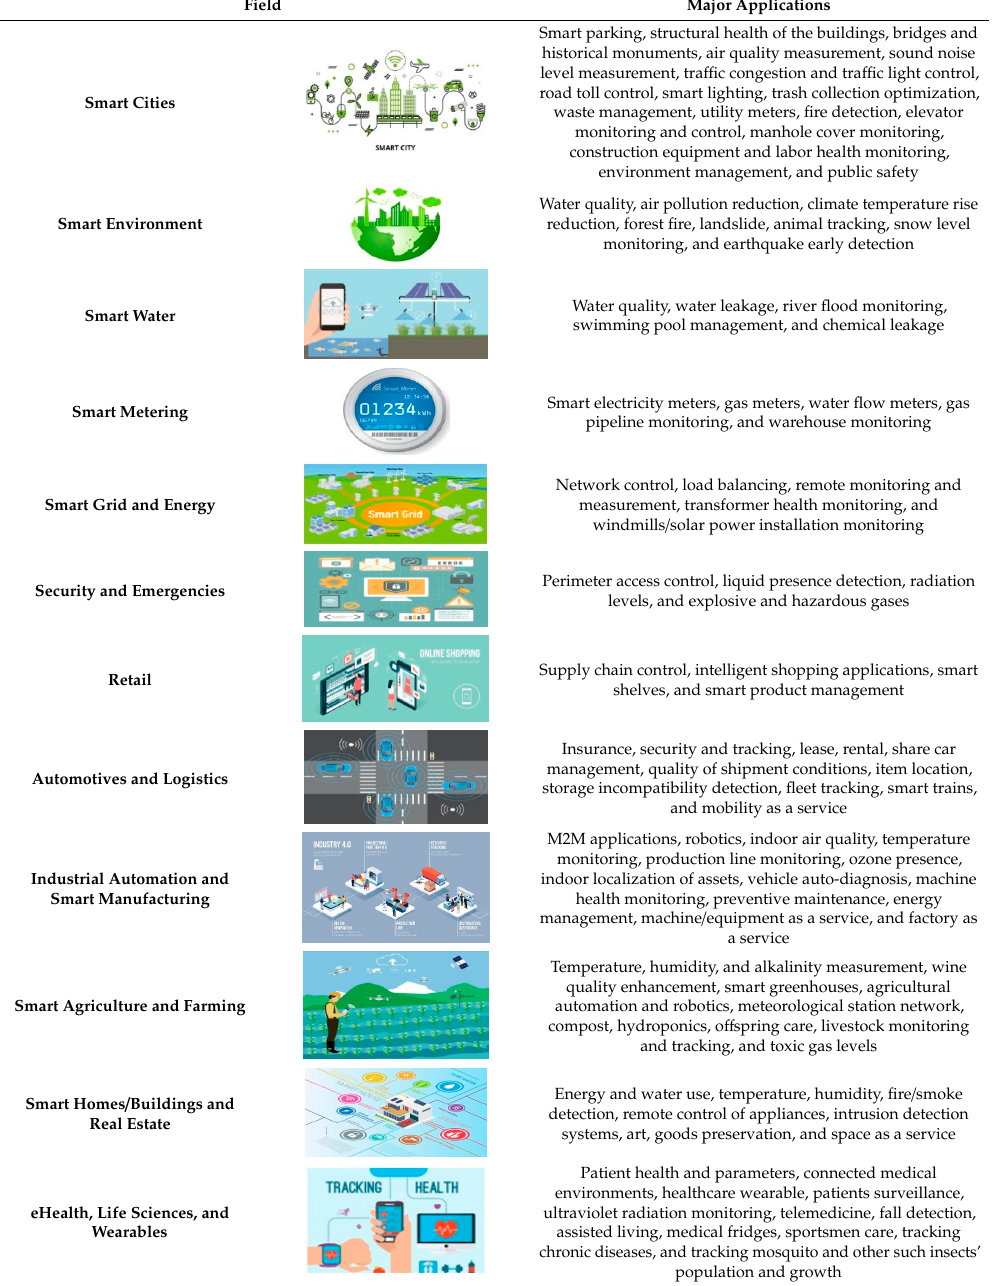
Table 1. Applications of low power wide area networks (LPWANs).